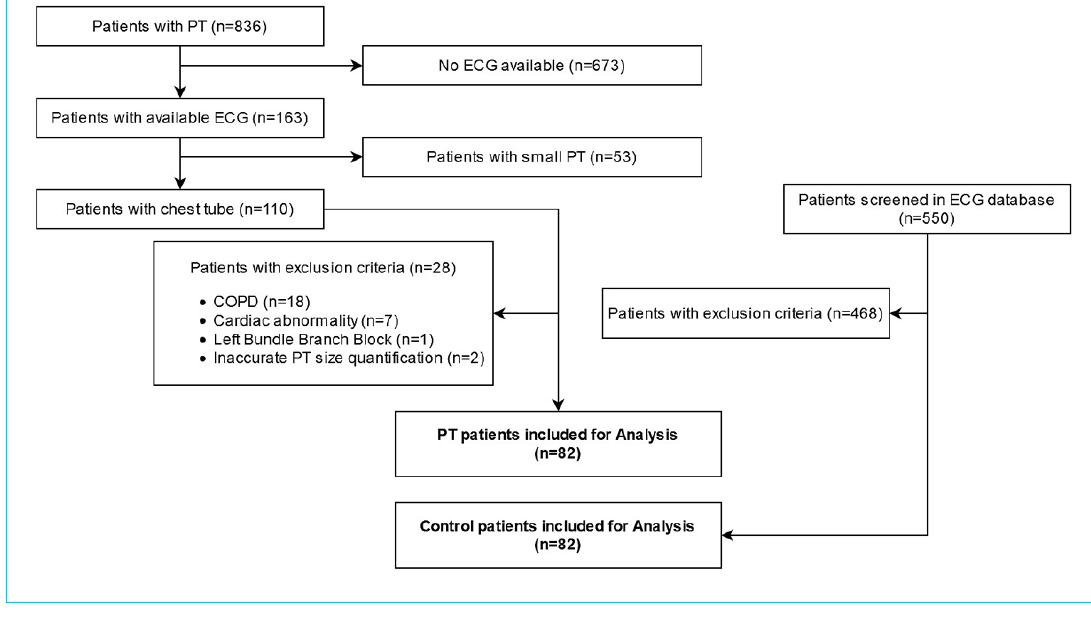
Figure 1: Flowchart of patient selection for the pneumothorax (PT) group. COPD = chronic obstructive pulmonary disease.